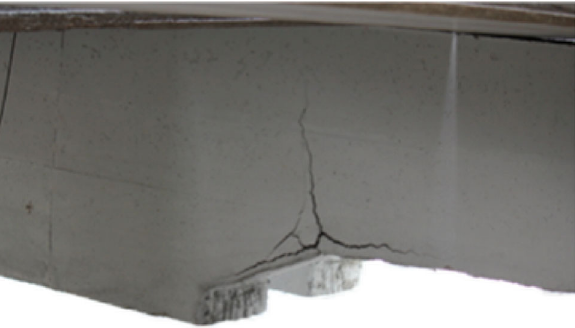
Fig. 1 Failure due to lack of